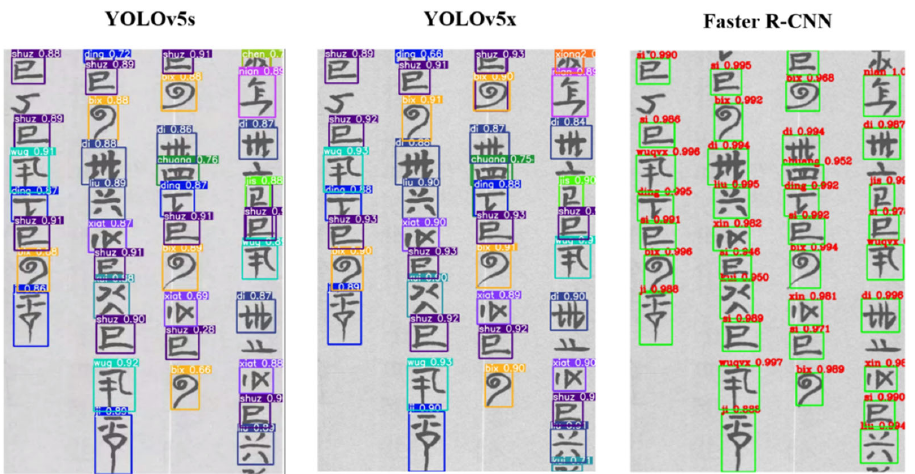
Figure 7. Image test results of YOLOv5s, YOLOv5x, and Faster R ‐